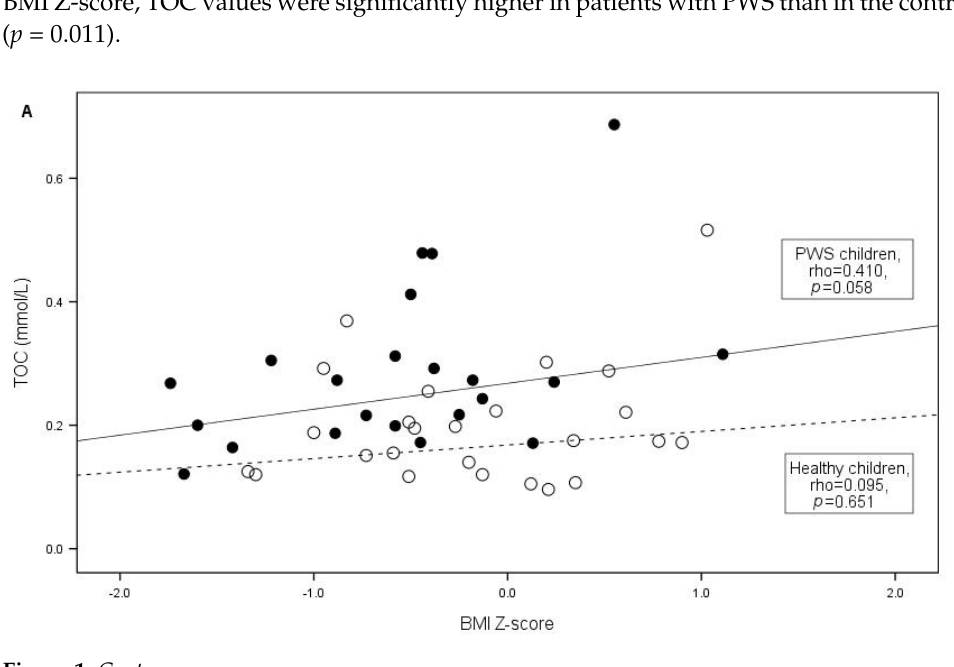
Figure 1. TOC values and BMI Z-score ( A ), fat mass percentage ( B ), and EER percentage ( C ) in chil- dren with PWS and controls. Black circles—PWS children, white circles—healthy children. Lines represent quantile regression.